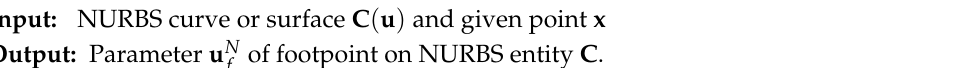
Algorithm 2 Algebraic point projection algorithm.